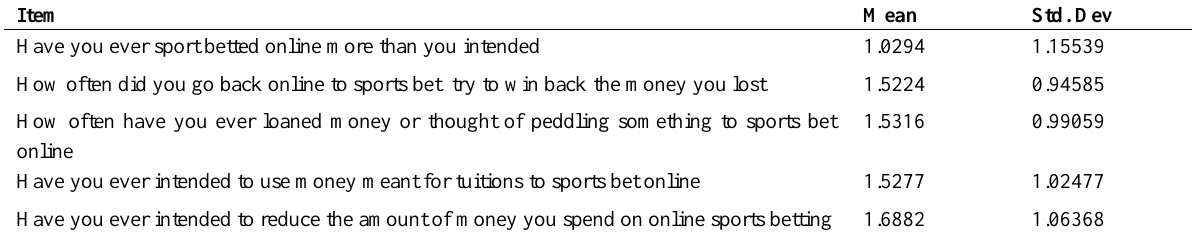
Table 4: Descriptive Results- Economic Wellbeing